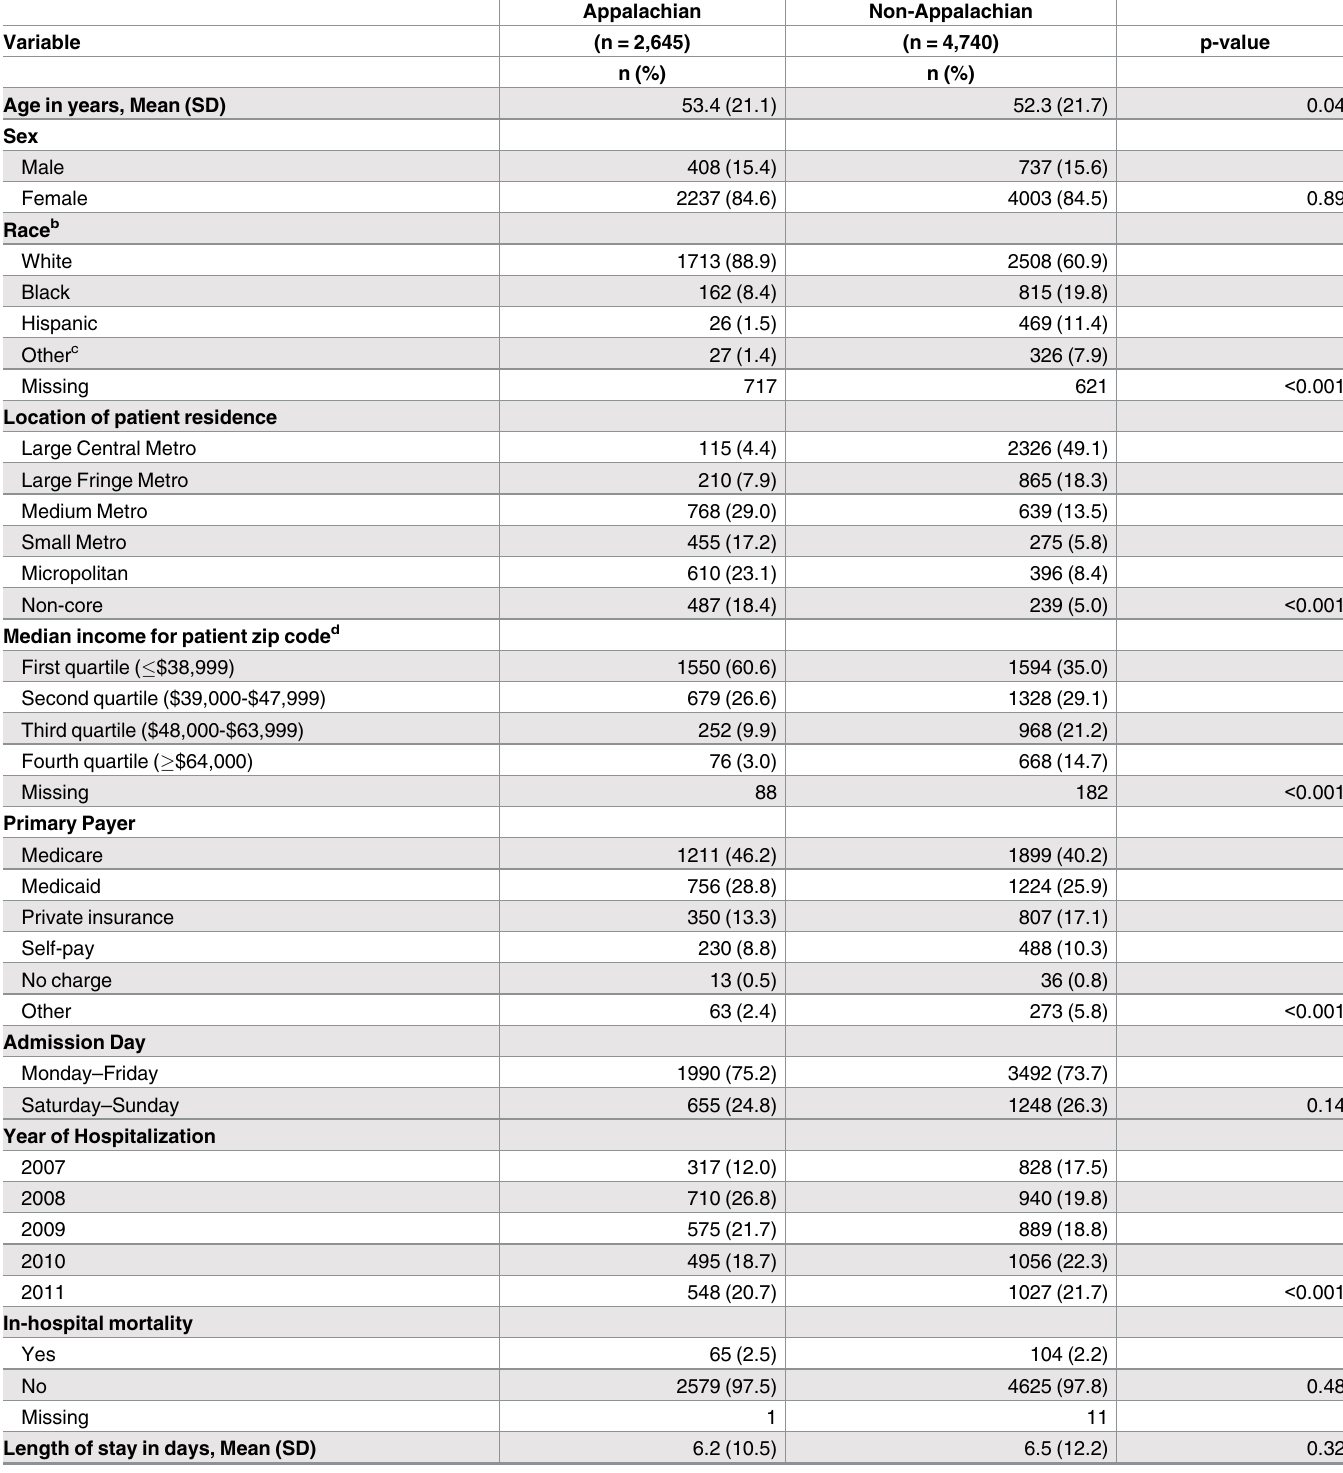
Table 1. Sociodemographic variables and hospitalization characteristics a